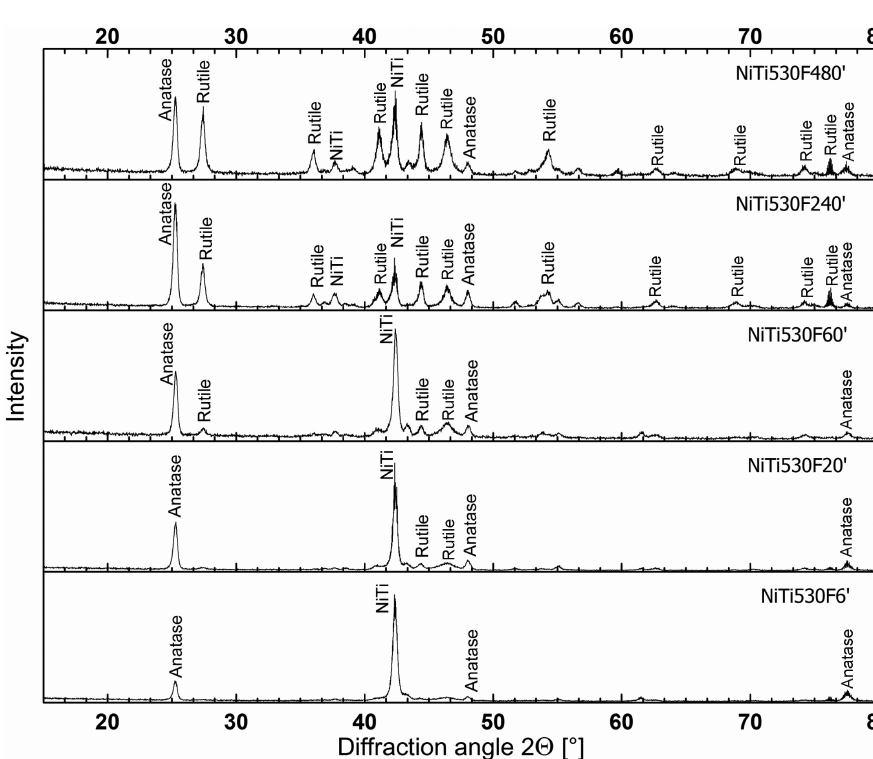
Figure 2. XRD patterns referents to 530 °C heat treated samples for 6, 20, 60, 240 and 480